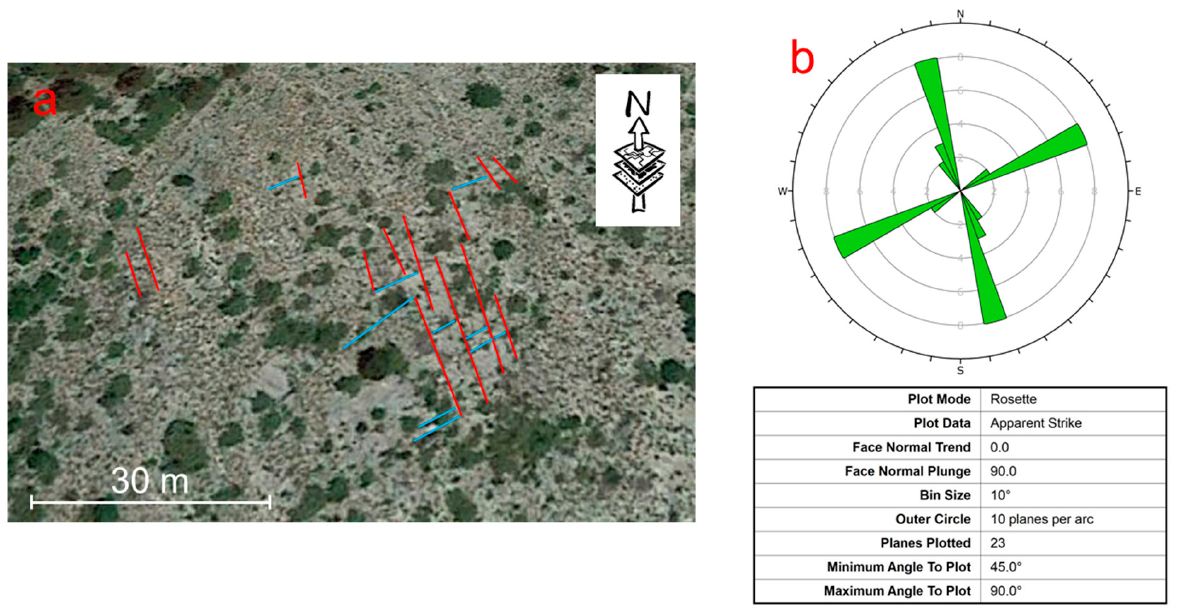
Figure 8. ( a ) the detection of strikes of daylighting discontinuities from a 2019 Google Earth image highlighted by red and blue lines, ( b ) a rosette plot showing the strike of detected discontinuities.